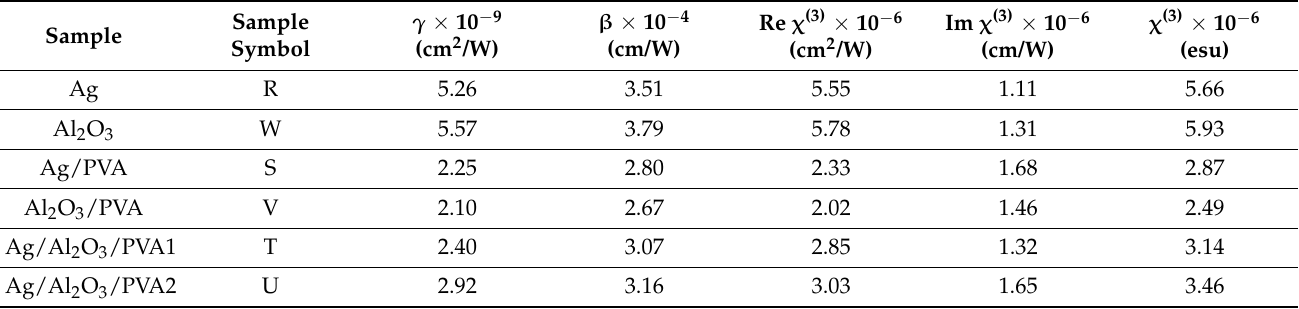
Table 1. Nonlinear optical parameters of different